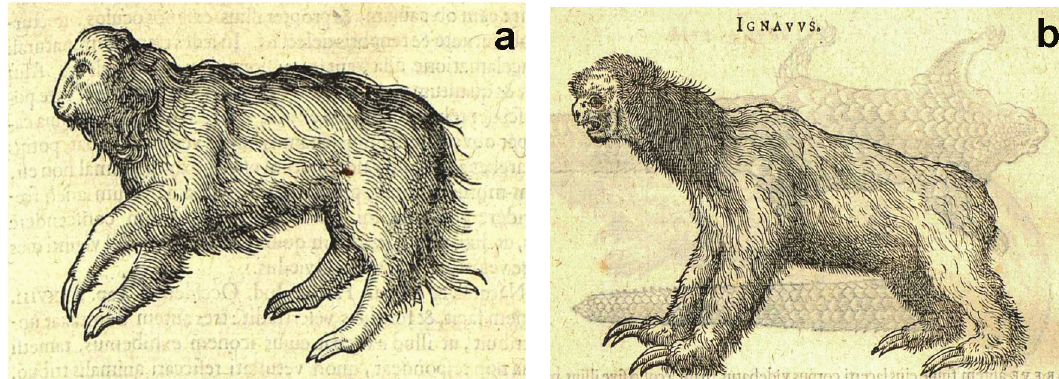
Figure 5 - (a) and (b) Ignavus . Woodcut of sloths by Carolus Clusius: (a) page 111 and (b) page 373 of Exoticorium Decem libri (1605). Public Domain: http://bibdigital.rjb.csic.es/ing/Libro.php?Libro=4727&Pagina=1.